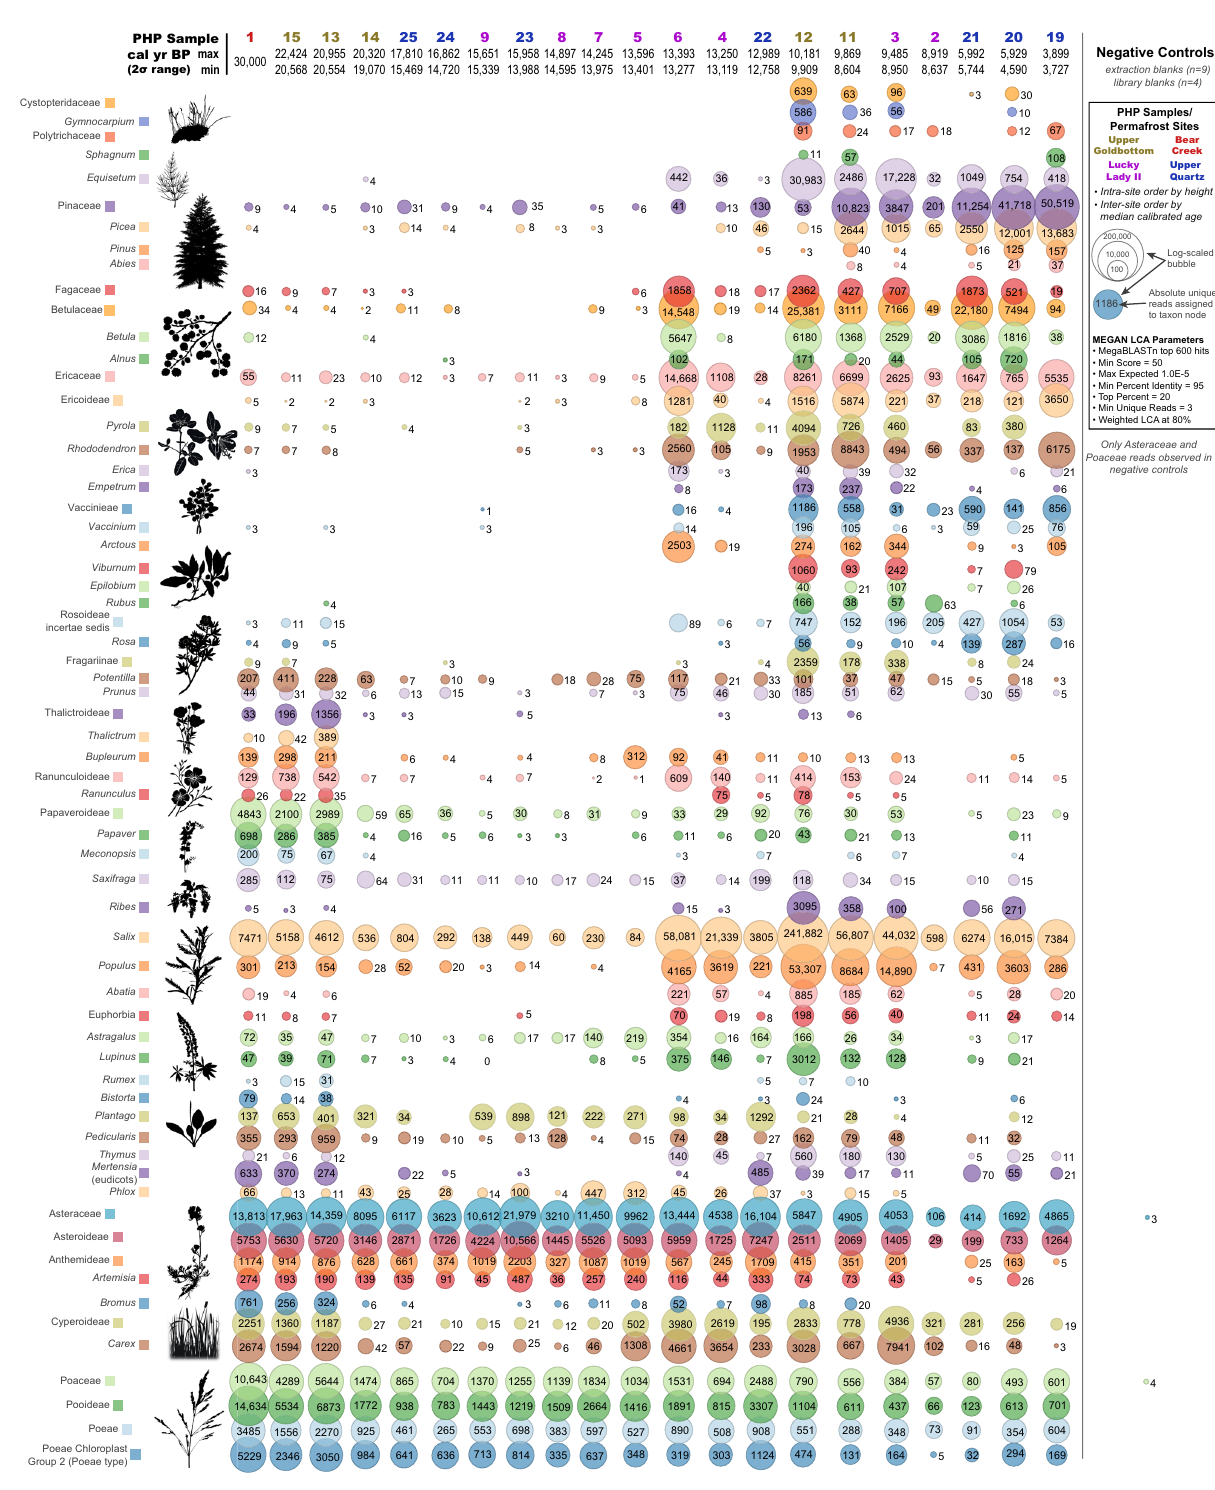
Fig. 4 Viridiplantae metagenomic comparison of permafrost core subsamples analyzed using BLAST n to MEGAN assigned reads. Values indicate unique reads assigned to that taxon node. Select taxon nodes depicted. Source data are provided as a Source Data fi